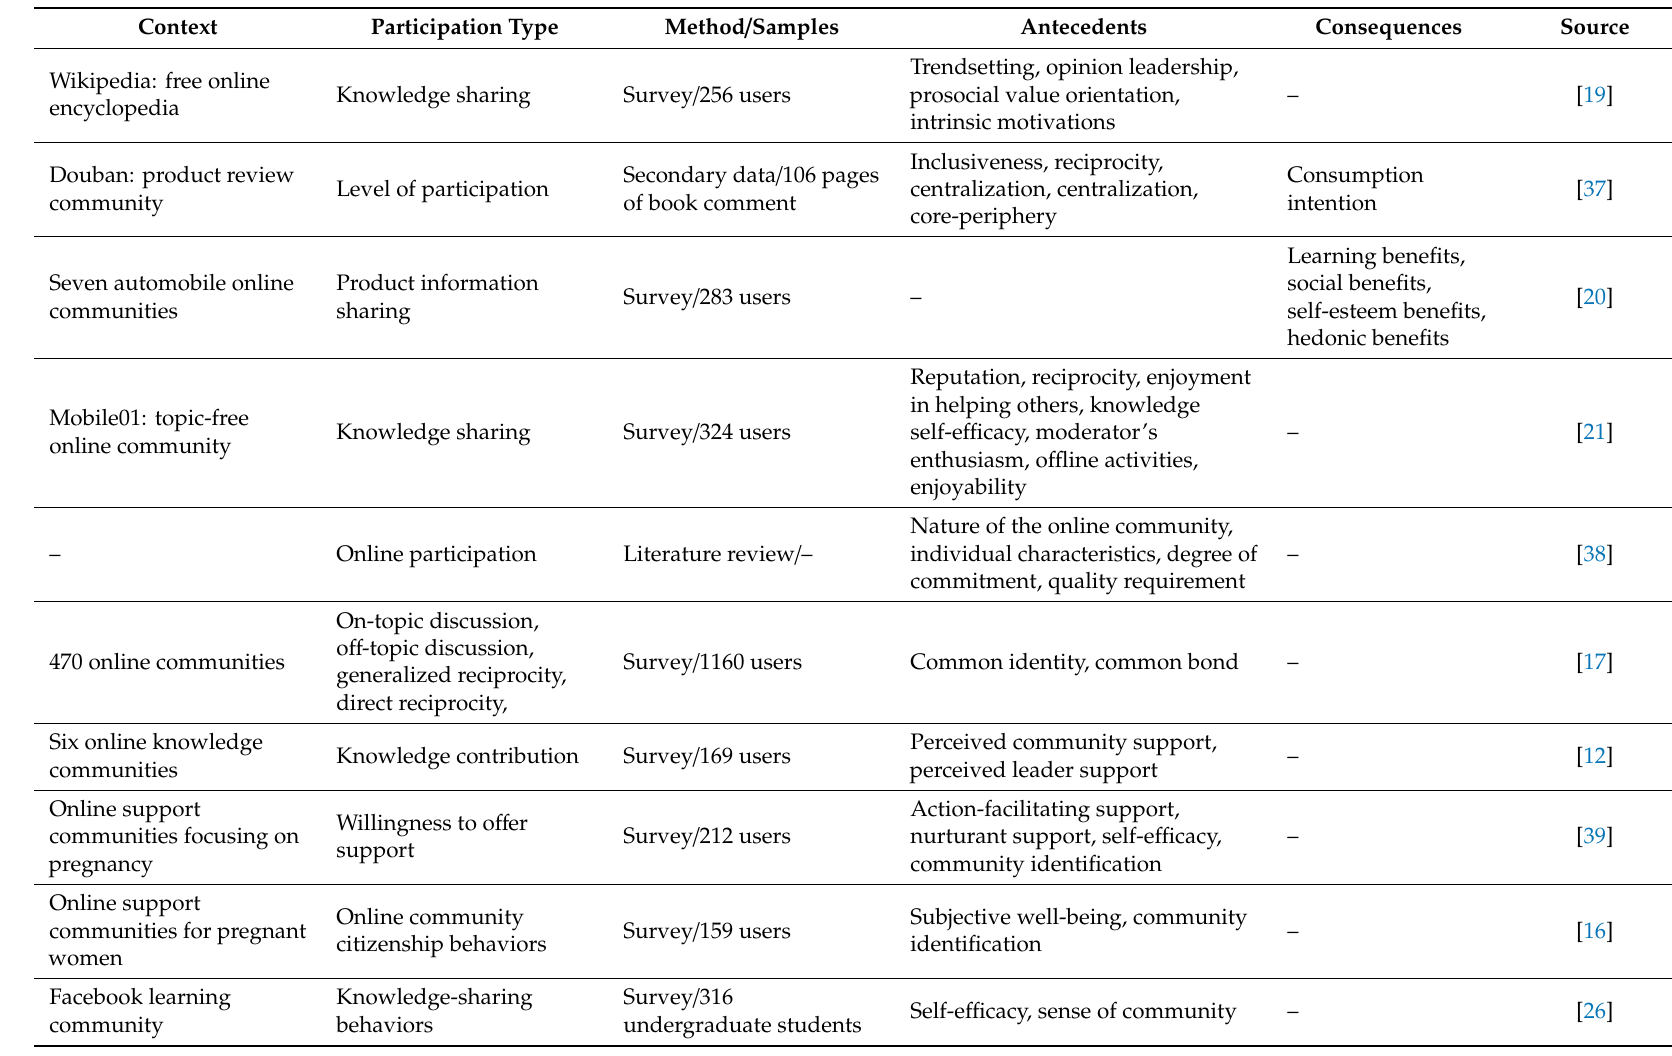
Table 1. Summary of studies on users’ participation in an online